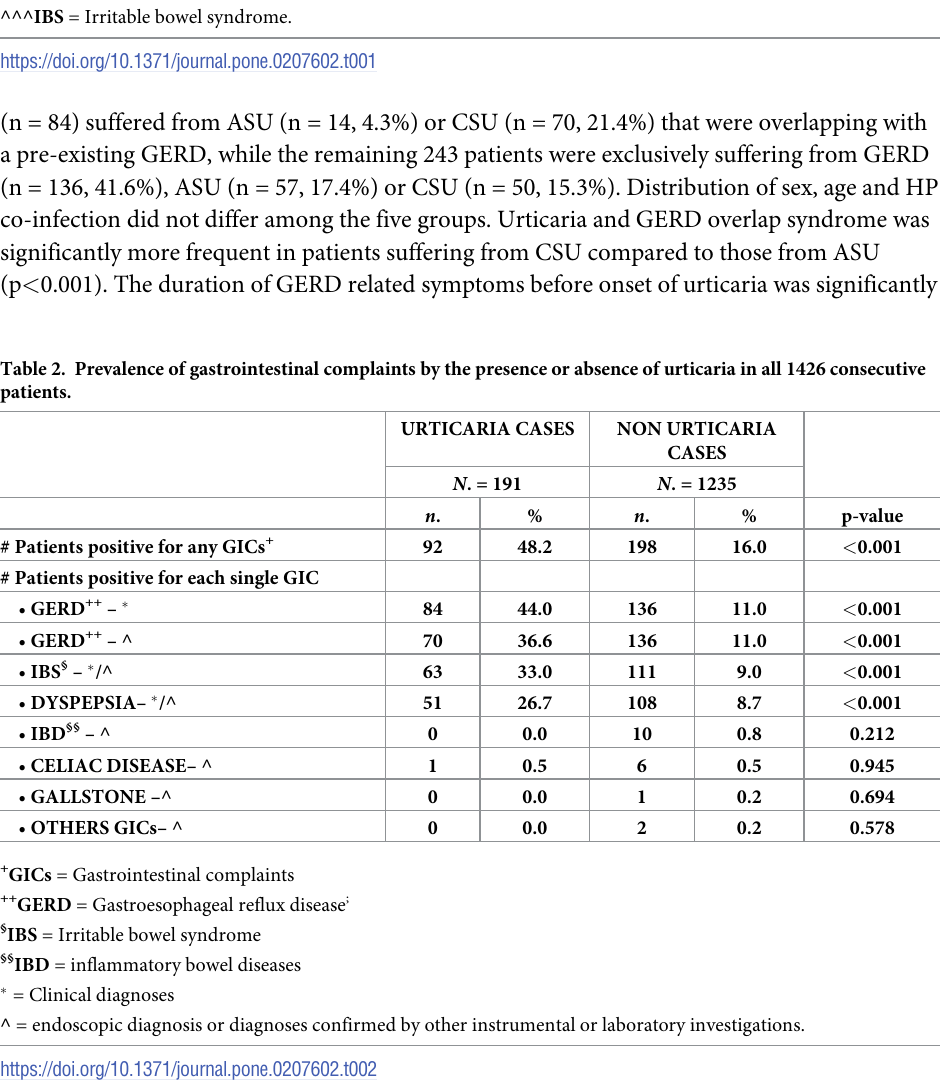
Overall prevalence